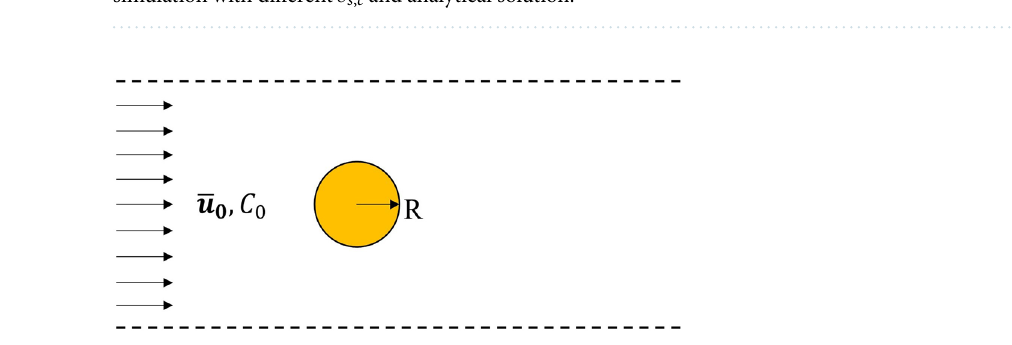
Figure 3. Position of liquid–solid interface as a function of nondimensional time obtained from mpFoam simulation with different ε s , c and analytical solution.